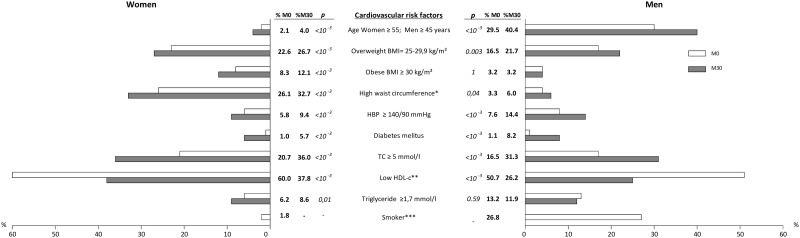
Changes in prevalence of different CV risk factors according to sex in patients with available data at M0 and M30, Temprano trial (N = 1724).* High waist circumference: ≥88 cm in women and ≥102 cm in men. **TC: total cholesterol. *** Low HDL-c: High density lipoprotein cholesterol, <1.2 mmol/l in women and <1 mmol/l in men. ****Smoker is defined as an individual who smokes at least one cigarette per day. BMI: body mass index; HBP: high blood pressure; HDL-c: high density lipoprotein cholesterol; P: p-value of Chi 2 test.